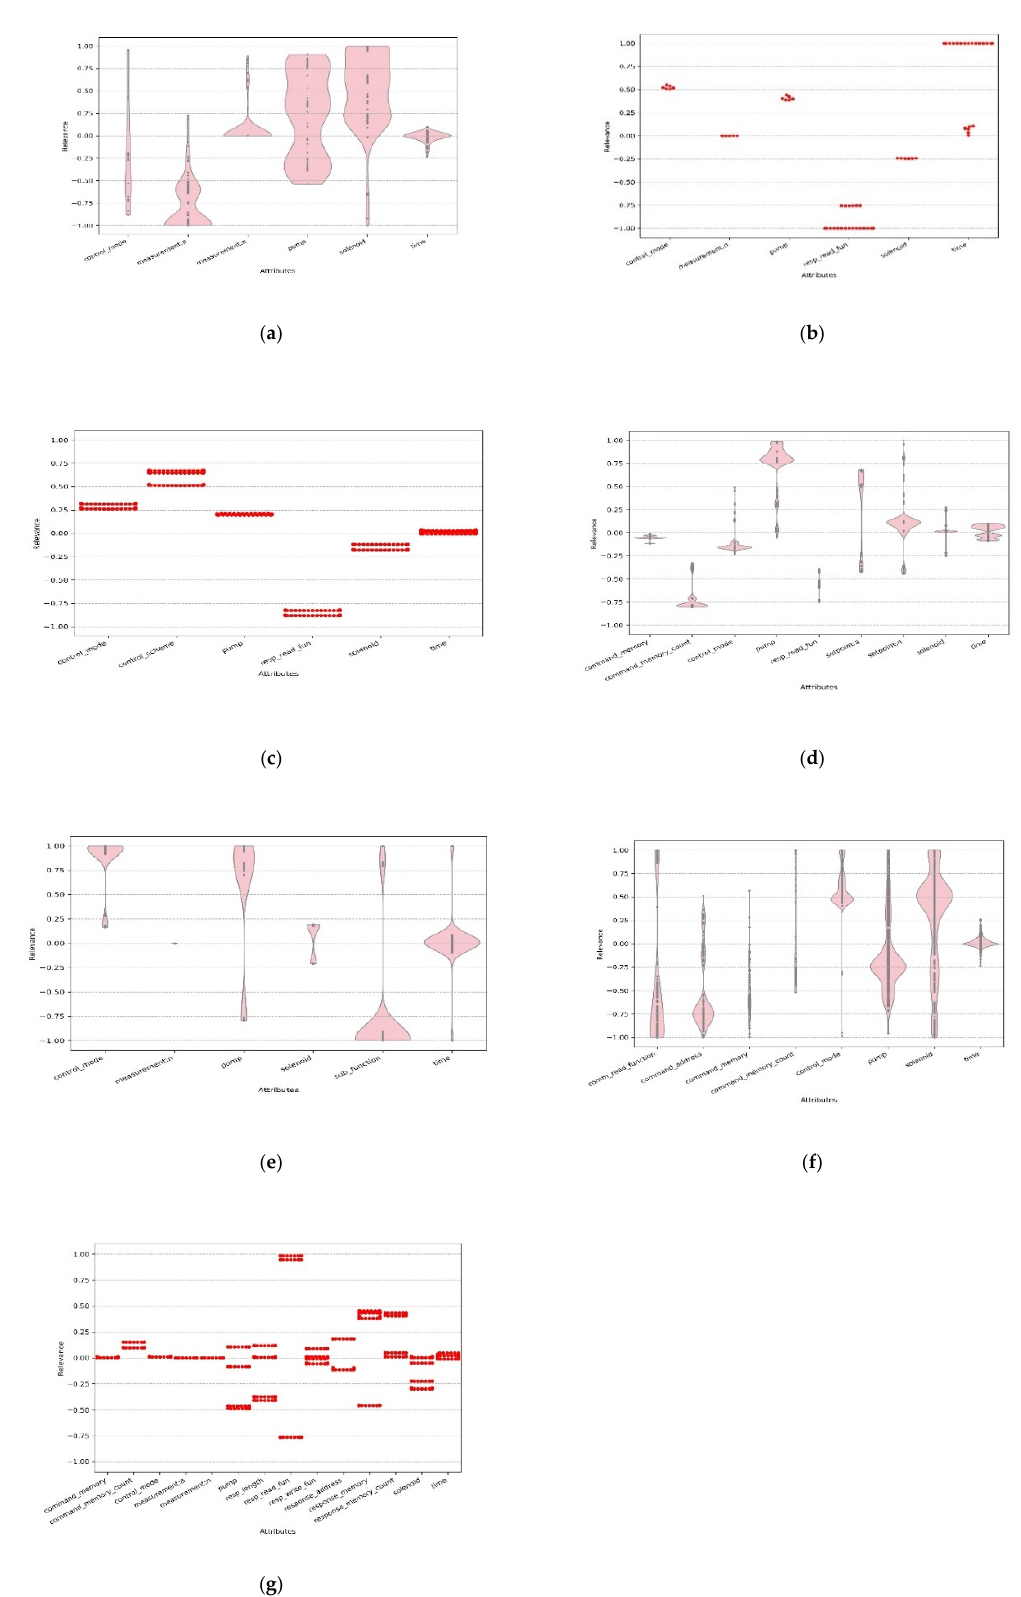
Figure 7. Result of relevance calculation: ( a ) NMRI, ( b ) CMRI, ( c ) MSCI, ( d ) MPCI, ( e ) MFCI, ( f ) DoS, and ( g )